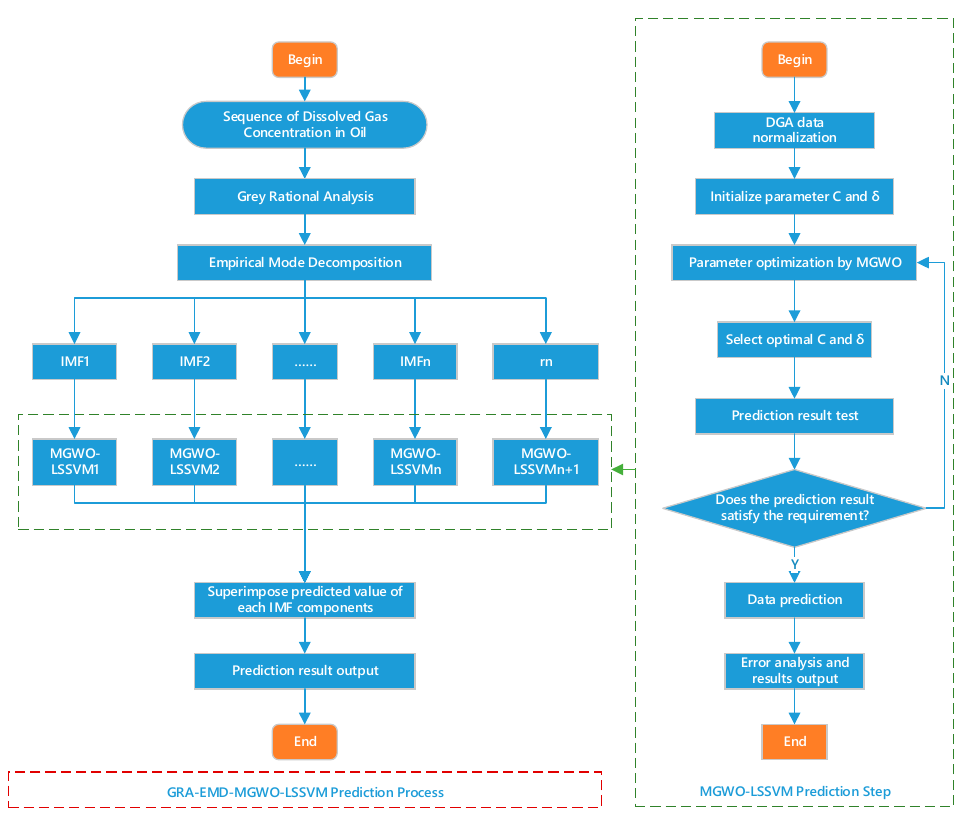
Figure 1. Flowchart of the prediction model based on grey relational analysis-empirical mode decomposition-modified gray wolf optimizer-least squares support vector machine (GRA-EMD-MGWO-LSSVM).